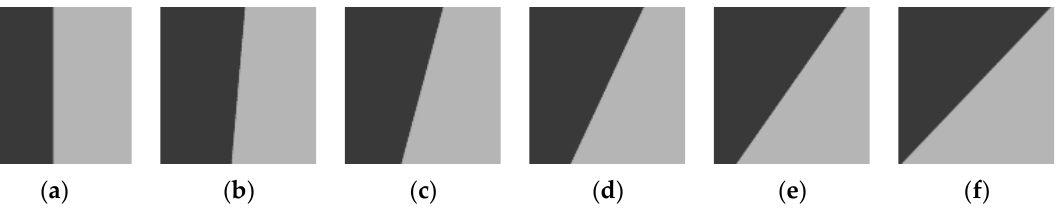
Figure 2. Partial simulated BDE image with different angles (0~45 deg): ( a ) when edge angle is 0 deg, ( b ) when edge angle is 5 deg, ( c ) when edge angle is 15 deg, ( d ) when edge angle is 25 deg, ( e ) when edge angle is 35 deg, ( f ) when edge angle is 45 deg.